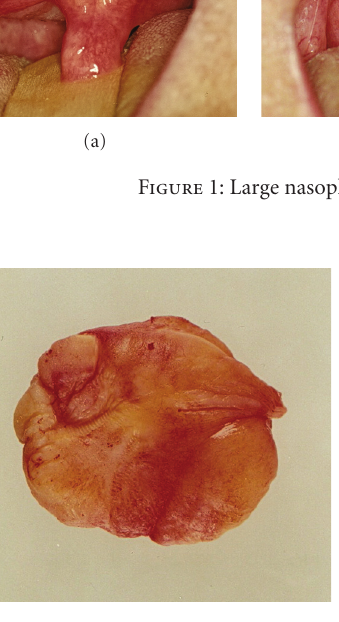
Figure 2: Pathology specimen.